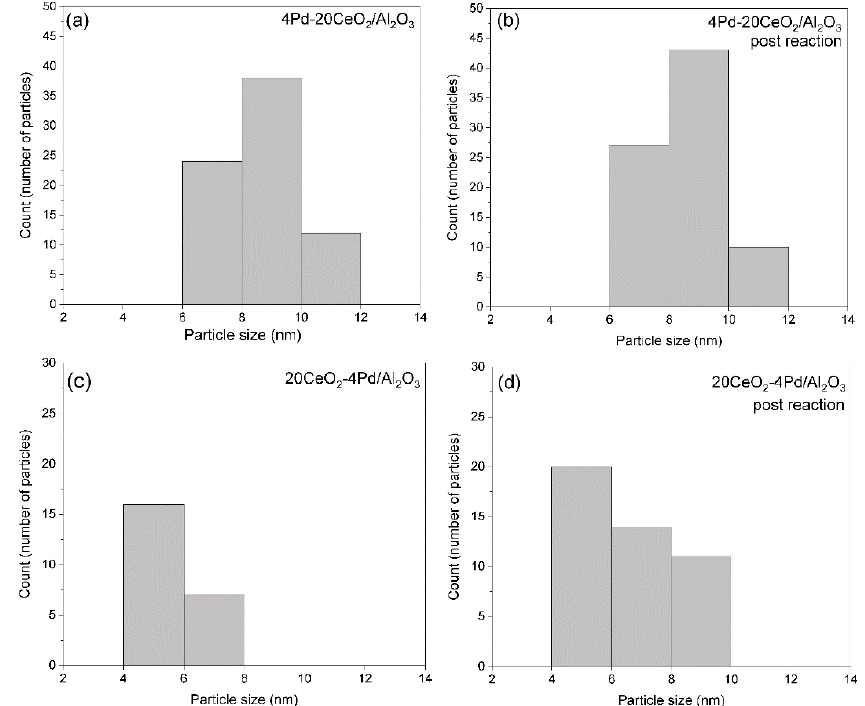
Figure 8. Morphology of 4Pd-20CeO 2 / Al 2 O 3 and 20CeO 2 -4Pd / Al 2 O 3 catalysts before and after reaction. ( a ) PdO particles are on alumina (black background) before reaction; ( b ) PdO particles are on alumina (black background) after reaction; ( c ) PdO particles are embedded on ceria before reaction; ( d ) PdO particles are embedded on ceria after reaction.